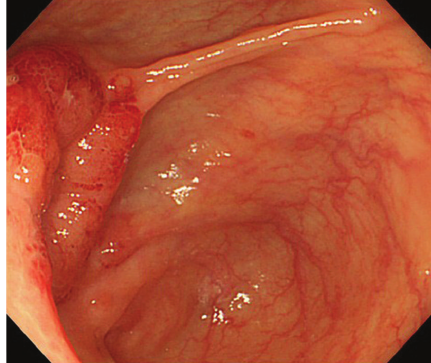
Figure 2: Endoscopic view of deformed and edematous ileocecal valve with erythema.